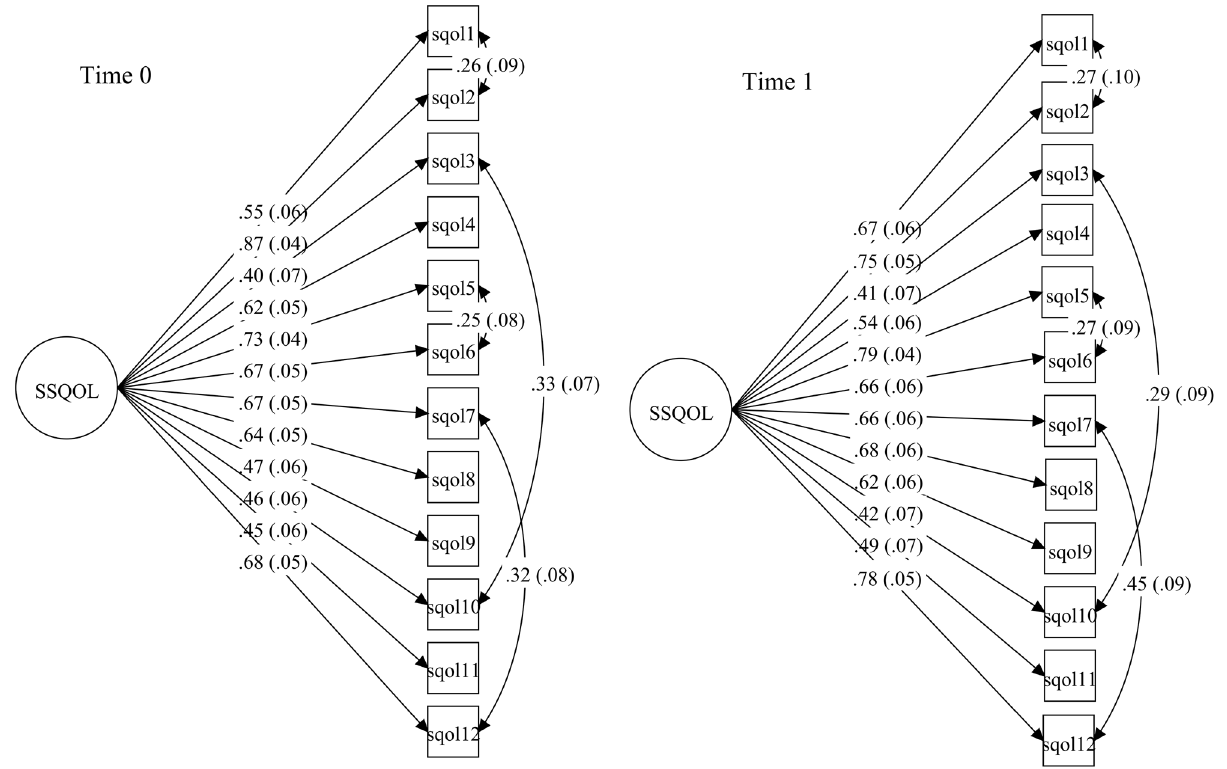
Figure 1. Factor structure ofthe modified 1-factor model of the 12-item Stroke-Specific Quality of Life Scale at baseline (Time 0) and 2-month follow-up (Time